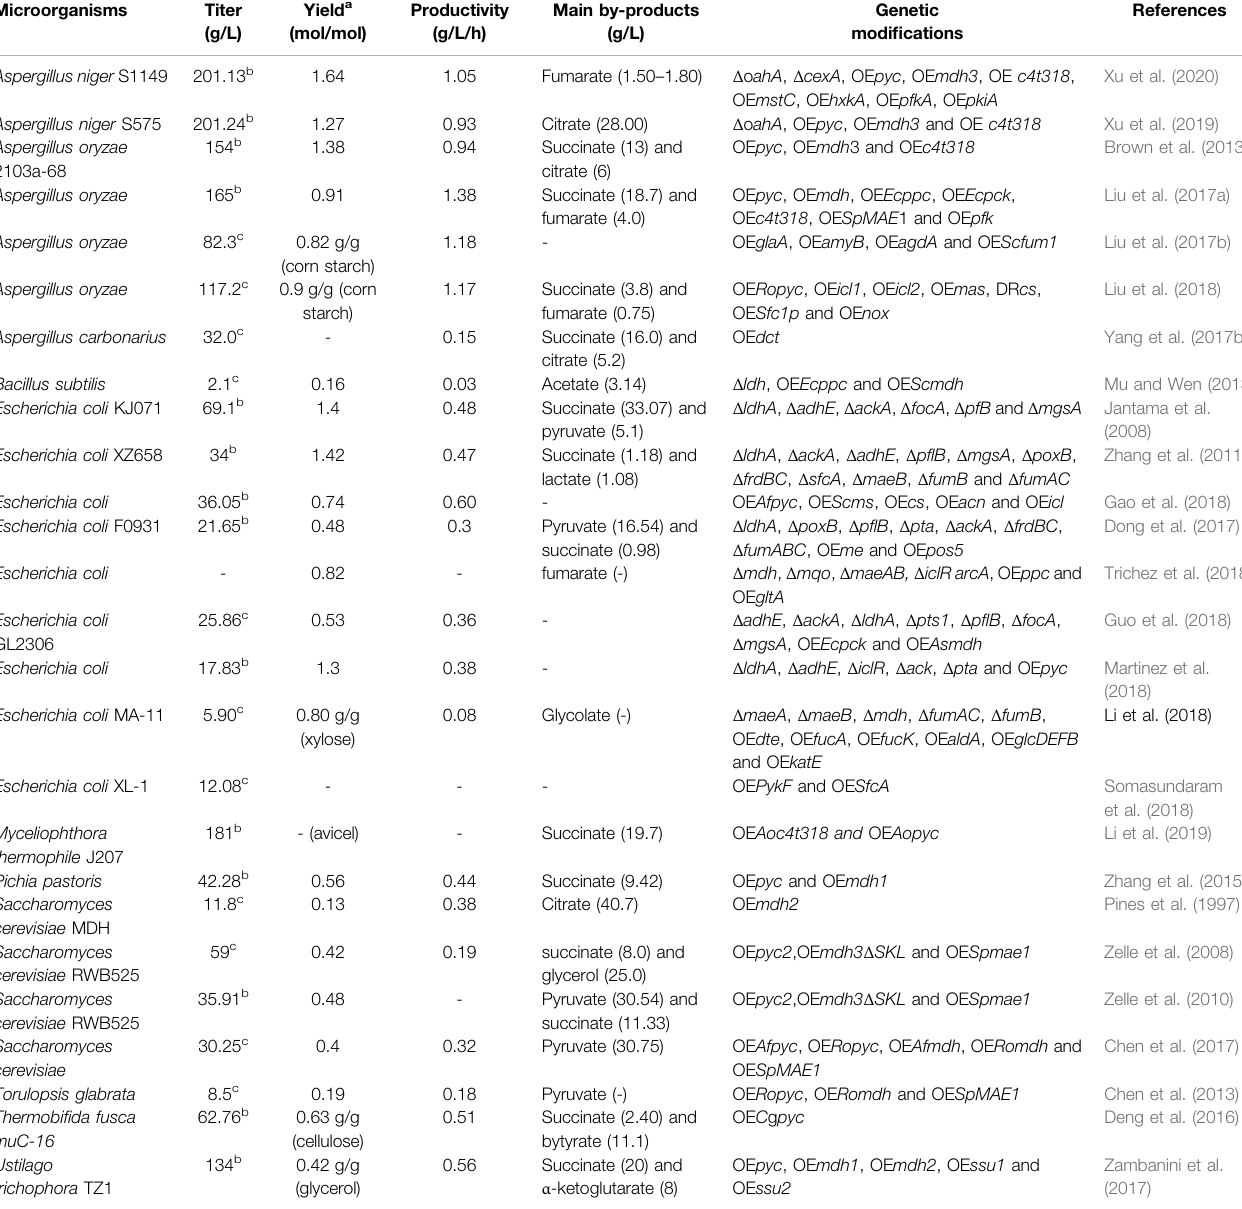
TABLE 3 | Malic acid production by metabolically engineered microorganisms. Microorganisms Titer